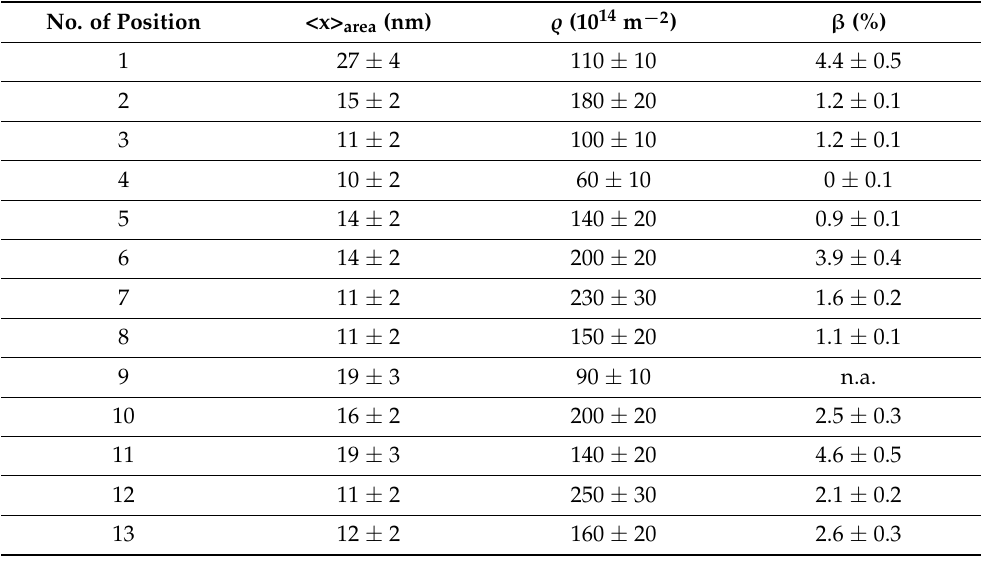
Table 2. The parameters of the microstructure (<x> area : area-weighted mean crystallite size; (cid:36) : dislocation density; and β : twin-fault probability) determined by XLPA.